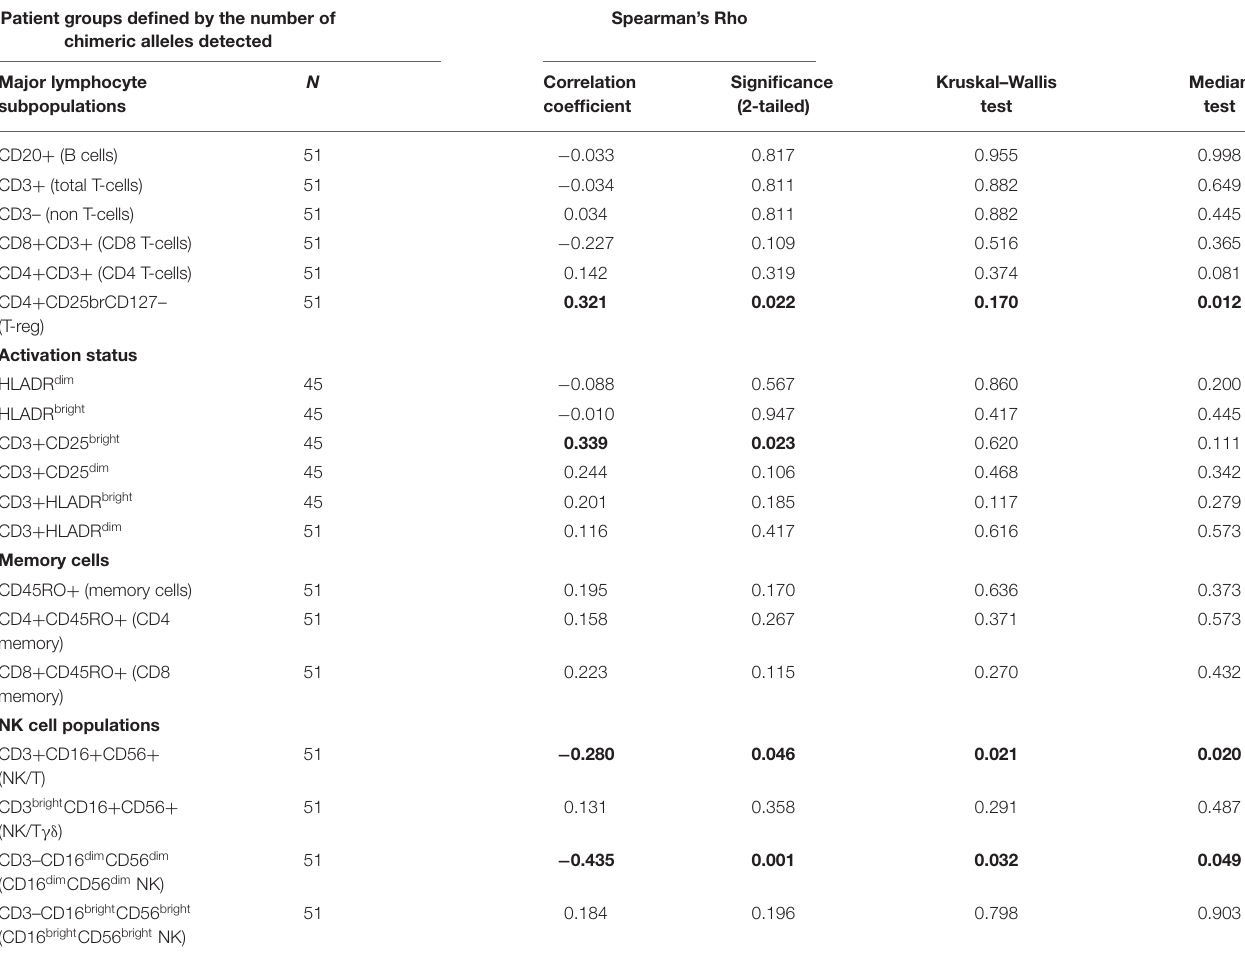
TABLE 5 | Results for the major lymphocyte subpopulations, examined across patients’ groups, defined by the number of chimeric alleles detected by PCR. Patient groups defined by the number of chimeric alleles